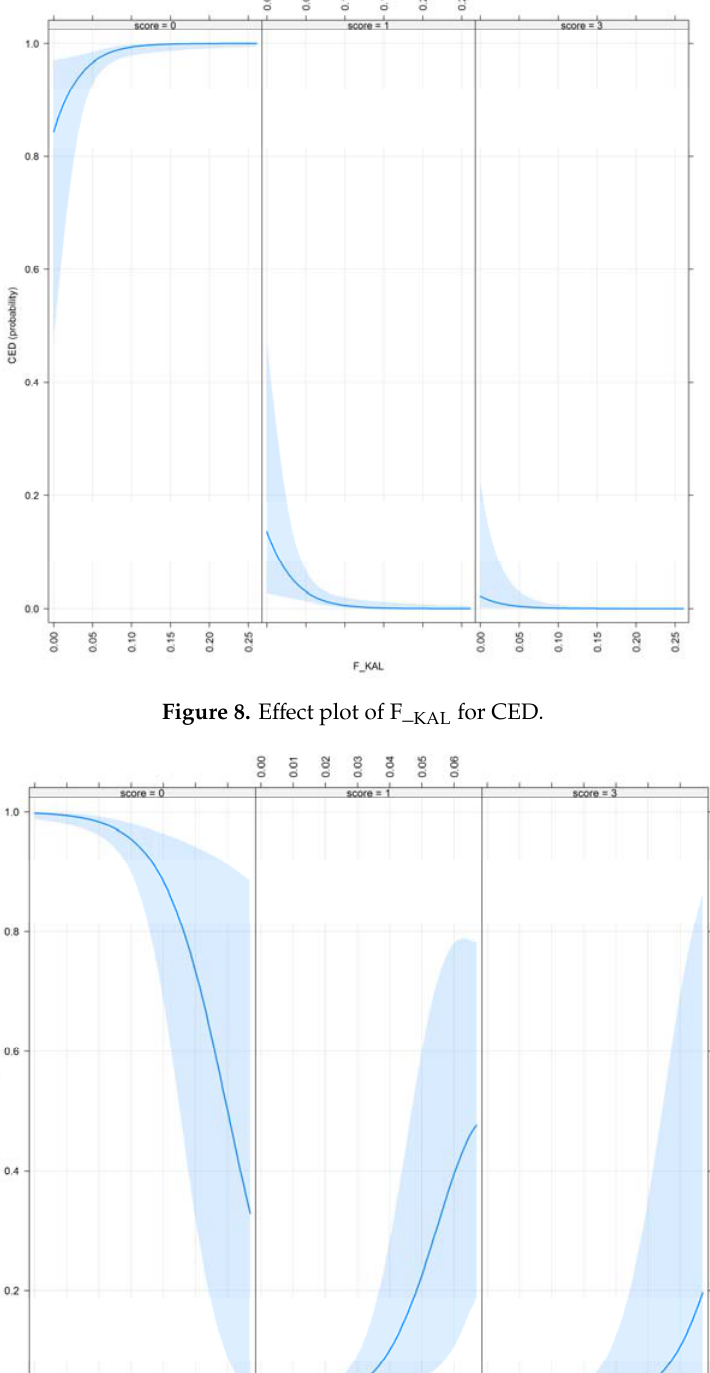
Figure 9. Effect plot of F_ KAL_NEW for CED. Figure 9. E ff ect plot of F_ KAL_NEW for